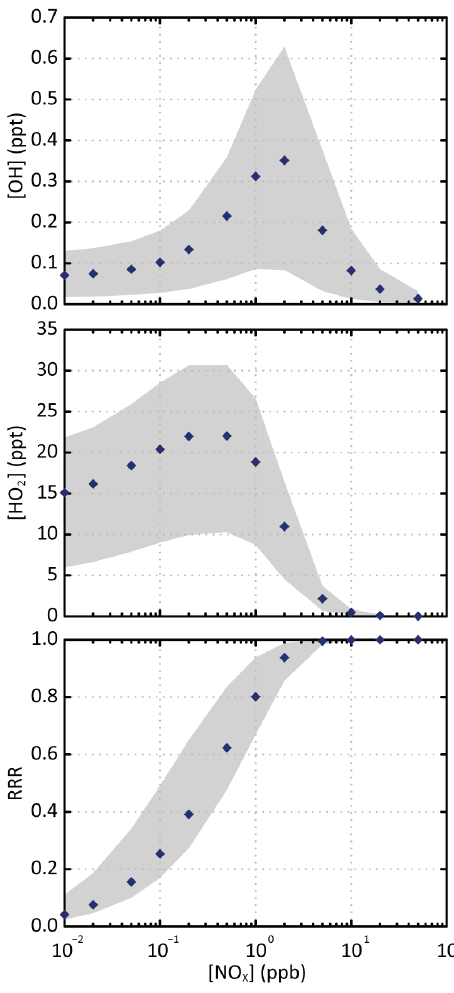
Figure 1. Simulated stationary state concentration of OH and HO 2 and corresponding reaction rate ratio (RRR) as a function of NO x concentrations for the various scenarios. The blue points are the simulated values for the scenario performed at a temperature of 298K, a zenith angle of 50 ◦ and 40ppb of ozone. The grey zone corresponds to the range of values simulated in all the